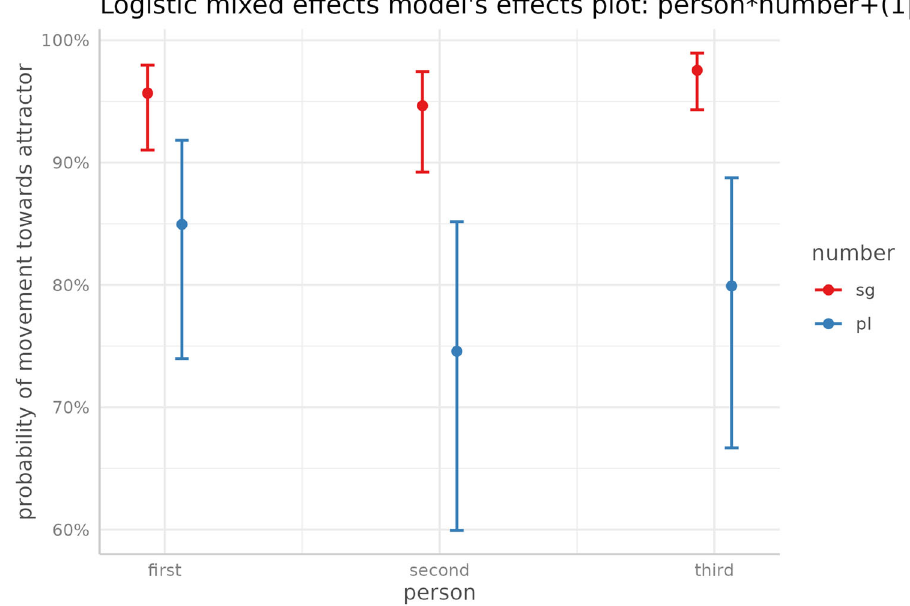
Fig. 3 Logistic mixed effects model ’ s predictions for the number of segments based on person and number (clade is used as a random